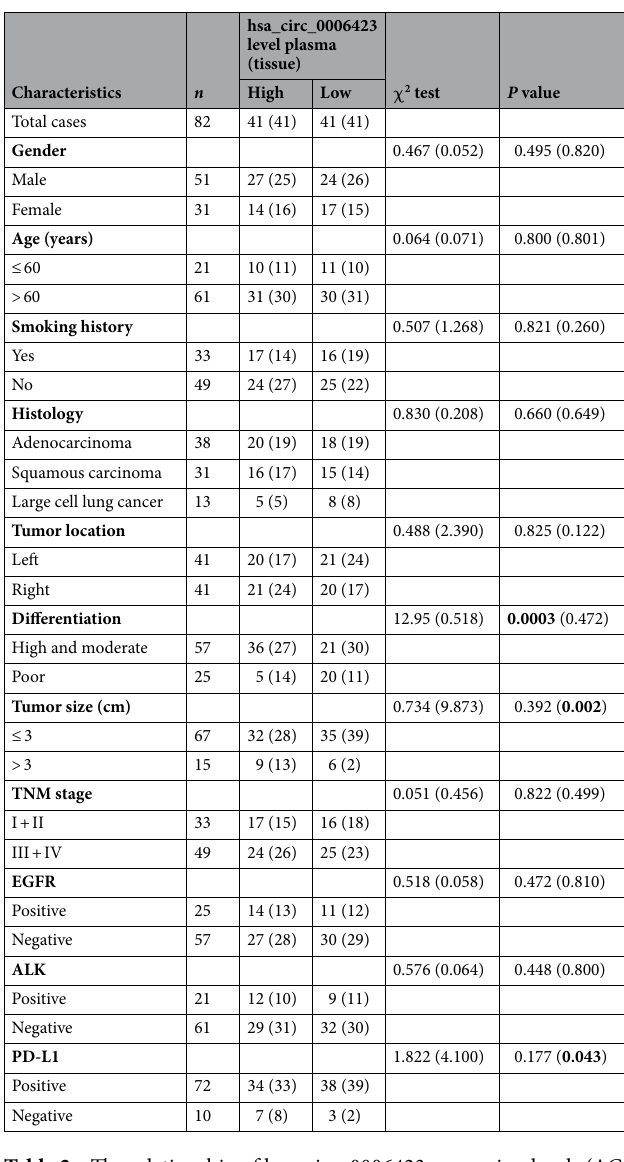
Table 2. The relationship of hsa_circ_0006423 expression levels (ΔCq) in NSCLC plasmas and tissues with clinicopathological factors of patients with NSCLC. EGFR epidermal growth factor receptor, ALK anaplastic lymphoma kinase, PD-L programmed cell death-Ligand 1. Significant values are in